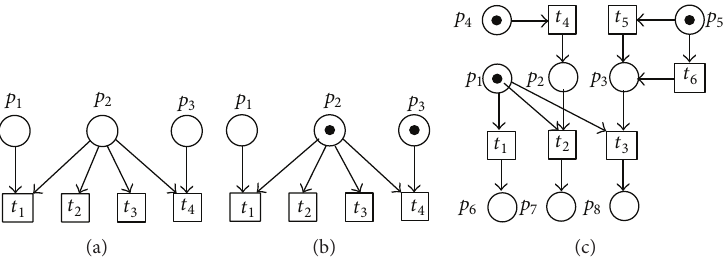
Figure 3: (a) A structural conflict 𝐾 = ⟨𝑝 2 , {𝑡 1 −𝑡 4 }⟩ , (b) an effective conflict 𝐾 𝑀 = ⟨𝑝 2 ,{𝑡 2 −𝑡 4 },𝑝 2 +𝑝 3 ⟩ , and (c) illustration of concurrency.